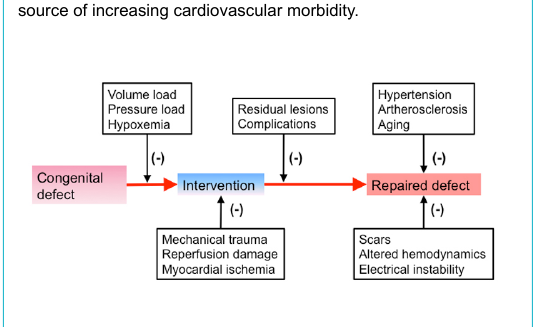
tients. Prior to the repair procedure or intervention, the haemody- namic consequences of the defect and hypoxaemia in cases of cyanotic conditions pose an increased load to one or both ventri- cles. Peri-interventional damage and residual lesions or sequelae contribute to the cardiovascular burden after repair. Over time, ag- ing and the emergence of acquired heart disease are an additional source of increasing cardiovascular morbidity.